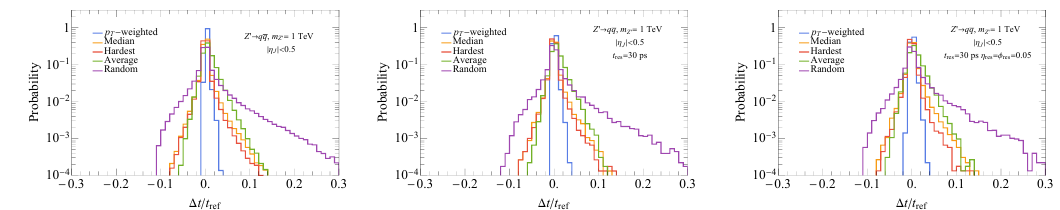
Figure 16 . The relative time difference distribution for | η J | < 0 . 5 with no detector effects (left), with time resolution added (center), and with time and spatial resolution added (right).